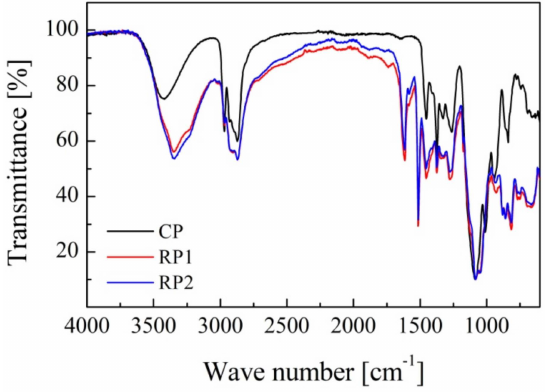
Figure 2. FTIR spectra of RPs and commercial polyol.